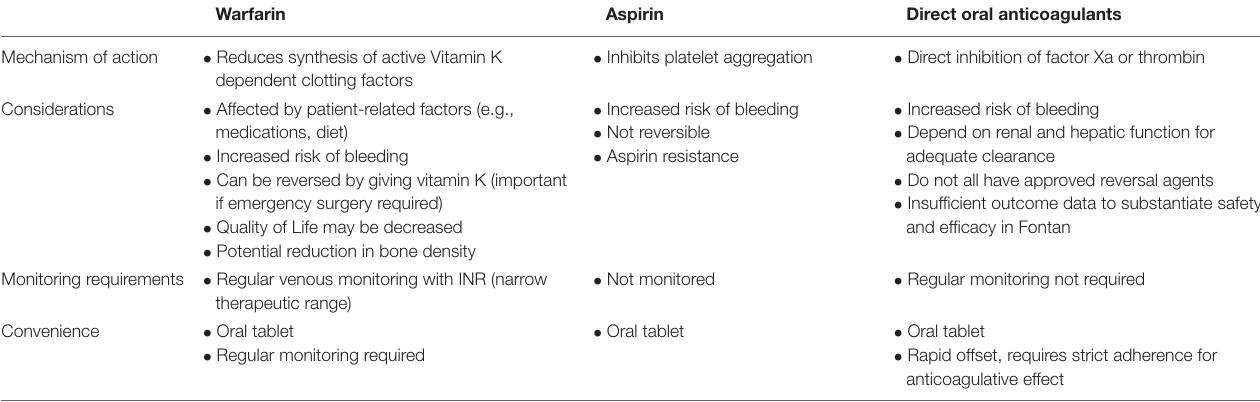
TABLE 1 | Comparison of considerations when prescribing warfarin, aspirin, and direct oral anticoagulants. Warfarin Aspirin Direct oral